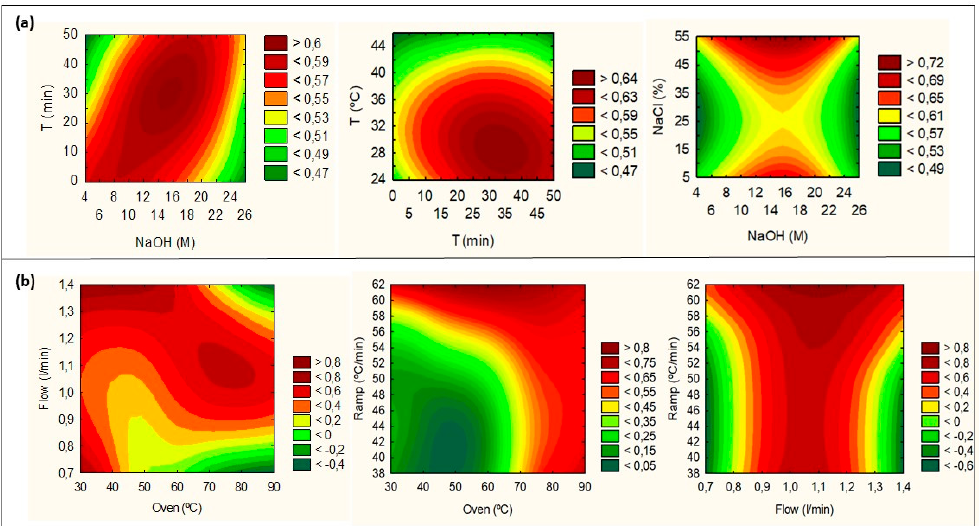
Figure 2. The e ff ects of all CMPs through the desirability surface contour method. ( a ) The desirability plots for HS-SPME(DVB / CAR / PDMS), and simultaneous analysis of the TPA and IP results. ( b ) The desirability plots for CG-MS(BP20), and simultaneous analysis of the TPA, IP, PR, TF, and SF results.